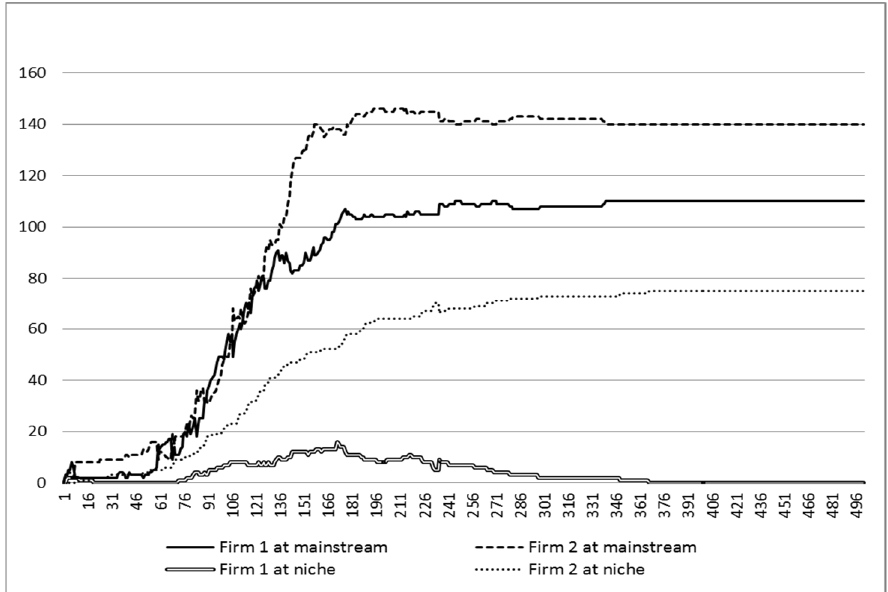
Figure 5. Competitive disruption, Firm 2 overtakes Firm 1 in the mainstream segment, the network effects is weak, and the preference in each segment is heterogeneous. effects is weak, and the preference in each segment is